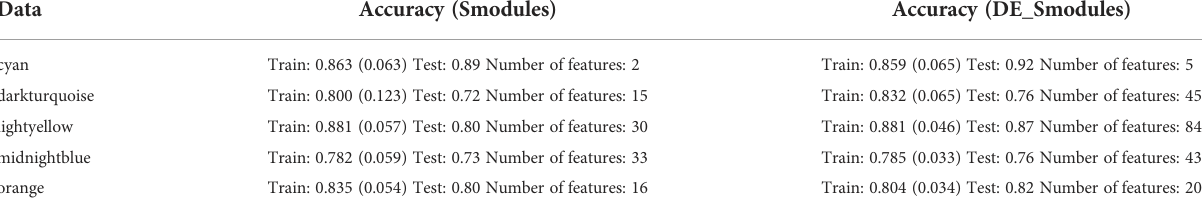
TABLE 3 Accuracy of train and test sets; and number of features when genes in Smodules and DE_Smodules were used. Data Accuracy